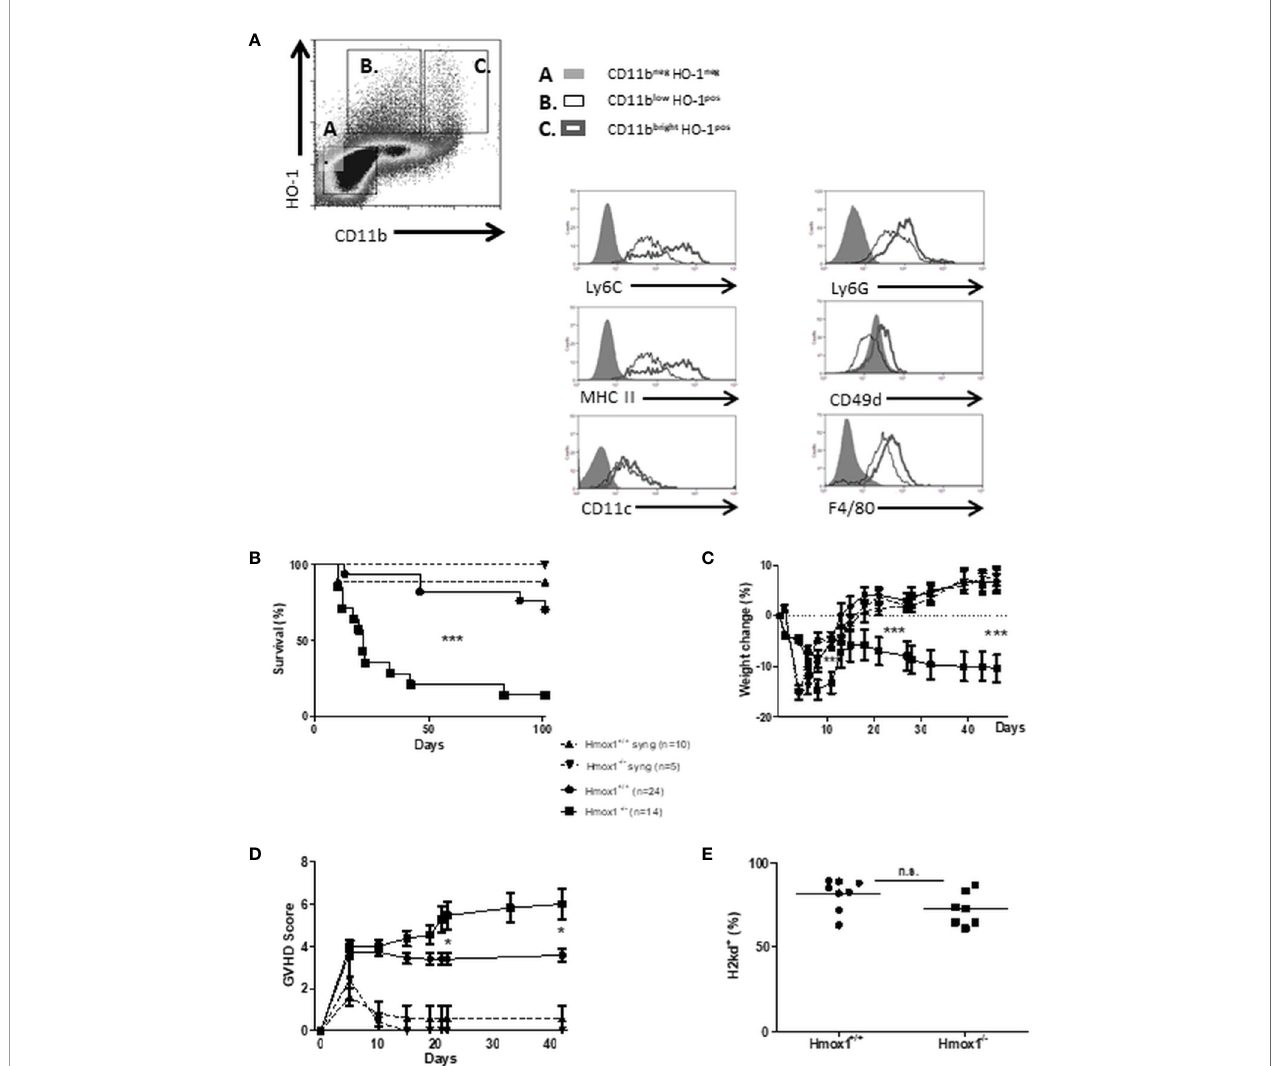
FIGURE 1 | Donor-derived HO-1 regulates GVHD and survival. (A) BM cells from HSCT recipients were harvested on day 7 posttransplantation and characterized by FACS analysis. Two cell populations (B, C) expressing intracytoplasmic HO-1 were identi fi ed, based on CD11b, Ly6C, Ly6G, CD49d, F4/80, and MHC-II expression. Results are representative of fi ve mice, seven days after transplantation. (B – D) GVHD characteristics were compared after syngeneic (BALB/c to BALB/ c) and allogeneic (BALB/c to C57BL/6) BM transplantation. In lethally irradiated hosts, 5 × 10 6 BM cells and 15 × 10 6 spleen cells from either wild type (WT) or Hmox1 − / − donors were injected. Survival (B) , % weight loss (C) and GVHD scores (D) were compared between groups. (E) Host reconstitutions by allogeneic (H2kd) BM and spleen cells are shown in peripheral blood monocytes (PBMCs). Three or four independent experiments involving 5 – 6 animals per group were pooled. n.s., no signi fi cant difference; * P <.05; ** P <.01; *** P